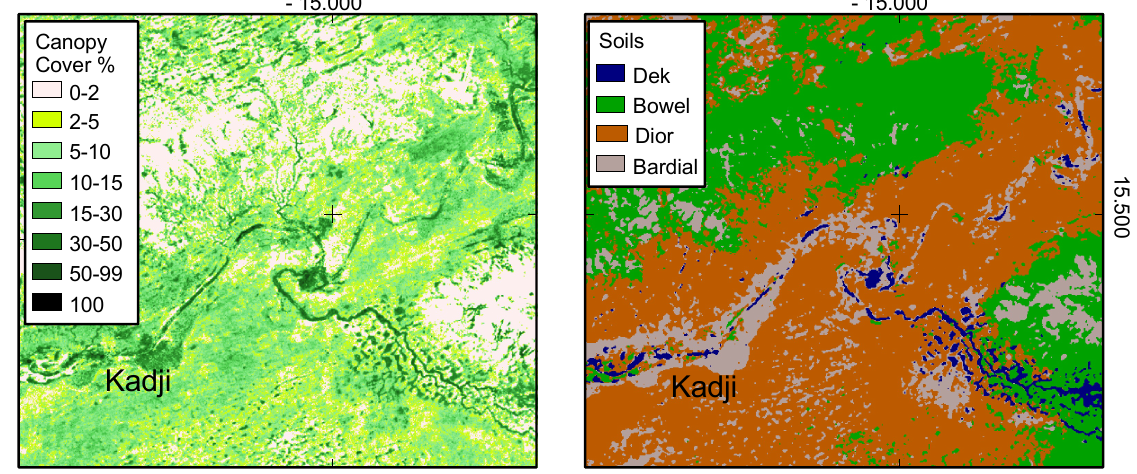
Figure 7. Woody cover ( left ) and soil types ( right ) around the Wolof villages Kadji and Kol Kol, north-east of Linguère. The Dior region with a sparse woody cover is mainly used for peanut cultivation while millet is grown on Bardial near the villages. Parts of the Bowel region are degraded and eroded with no woody vegetation left, as they are not suitable for cropping and thus serve as a source for fuel-wood. Dek are flooded during the rainy season.